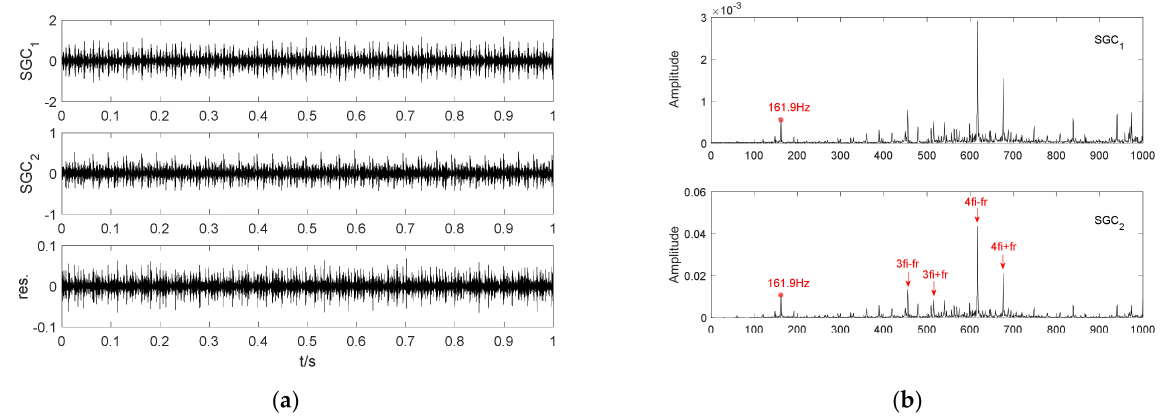
Figure 12. The decomposition results of SGMD-CS: ( a ) Time domain; ( b ) Frequency domain.